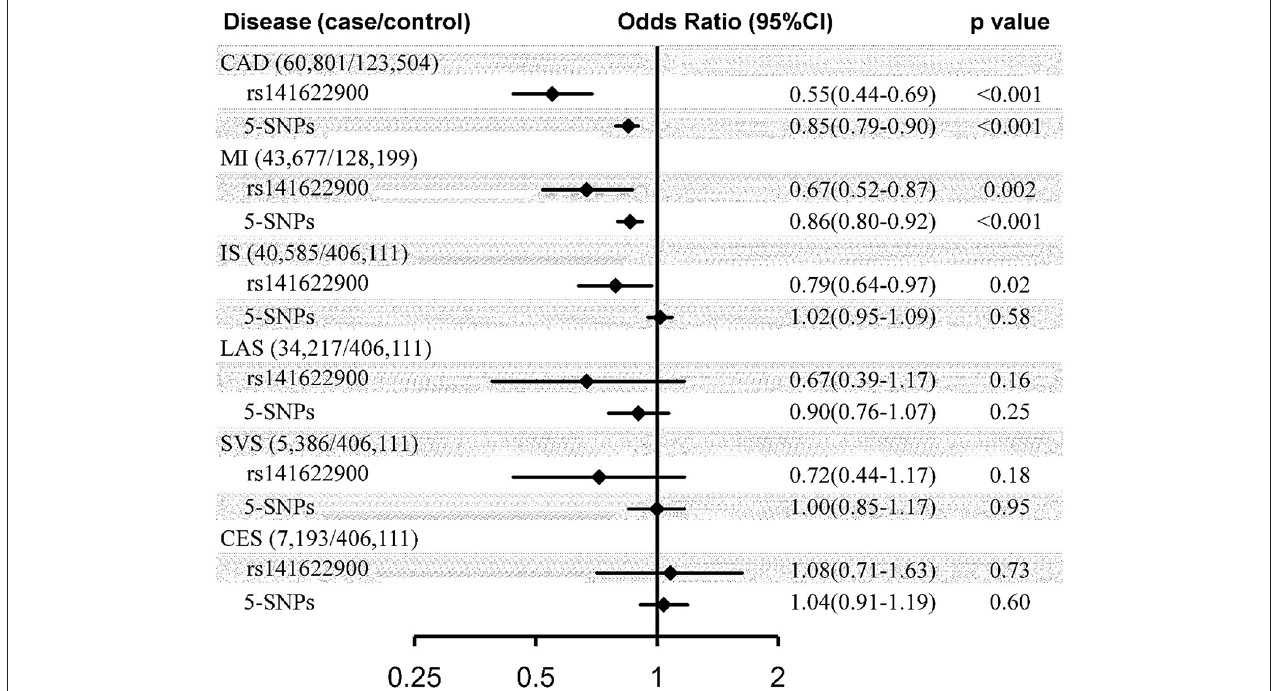
FIGURE 1 | Causal effect estimates of genetically predicted cholesterol efflux capacity on coronary artery disease and stroke. Estimates represented odds ratio (95% CI) per SD genetically higher cholesterol efflux capacity derived from Wald ratio method using rs141622900 as the instrument and inverse-variance weighted